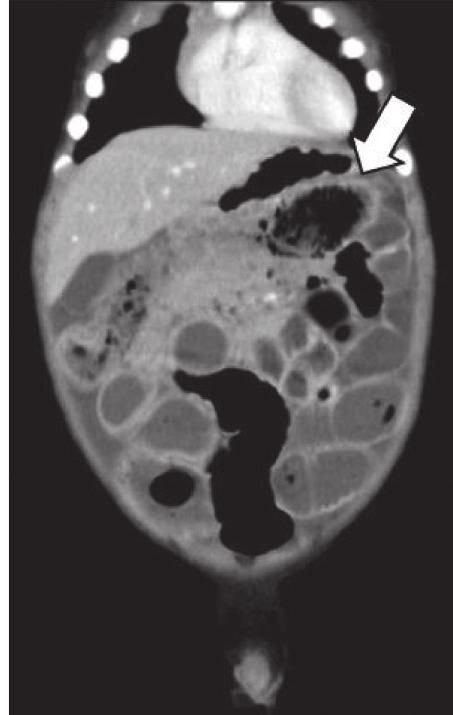
Figure 2: An abdominal computed tomography revealed fecalo- mas in the transverse colon (arrow), bowel distension from the jejunum to the transverse colon, and moderate ascites.